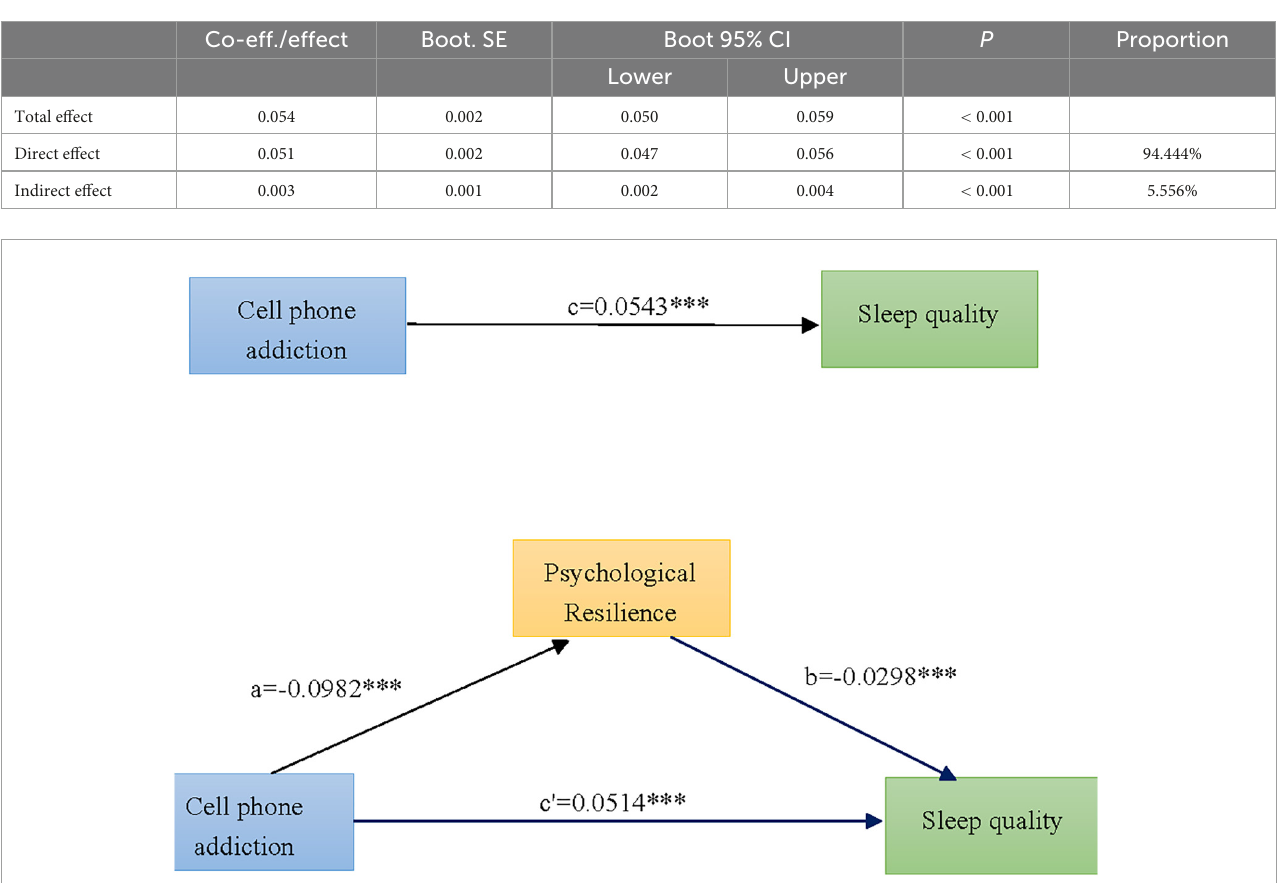
FIGURE2 Mediating effect of psychological resilience between cell phone addiction and sleep quality among 7,234 college students. c-Total effect of cell phone addiction on sleep quality; a-Effect of cell phone addiction on the mediating variable psychological flexibility; b-Effect of psychological flexibility on sleep quality after controlling for the effect of cell phone addiction; c (cid:48) -Direct effect of cell phone addiction on sleep quality after controlling for the effect of psychological flexibility; mediating effect value = a × b. ∗∗∗ P <